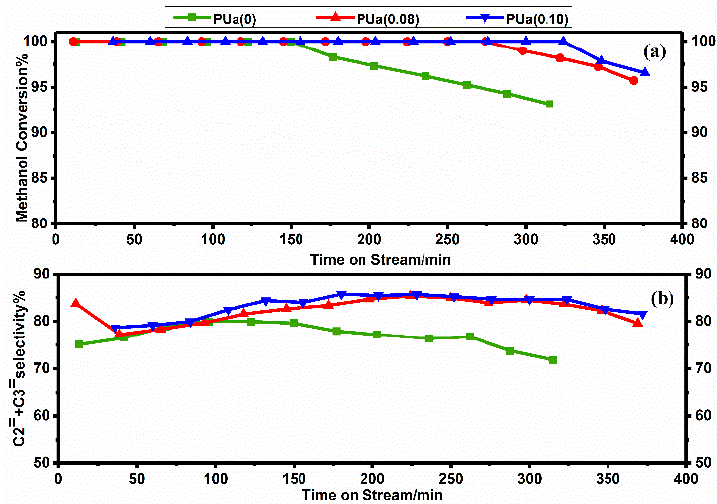
Figure 11. Methanol conversion ( a ) and product selectivity ( b ) as a function of time on stream, catalyst: 0.5 g (mixed with 1 g SiC), temperature 420 ◦ C, N 2 flow rate = 20 mL · min − 1 , WHSV = 1.5 h − 1 .